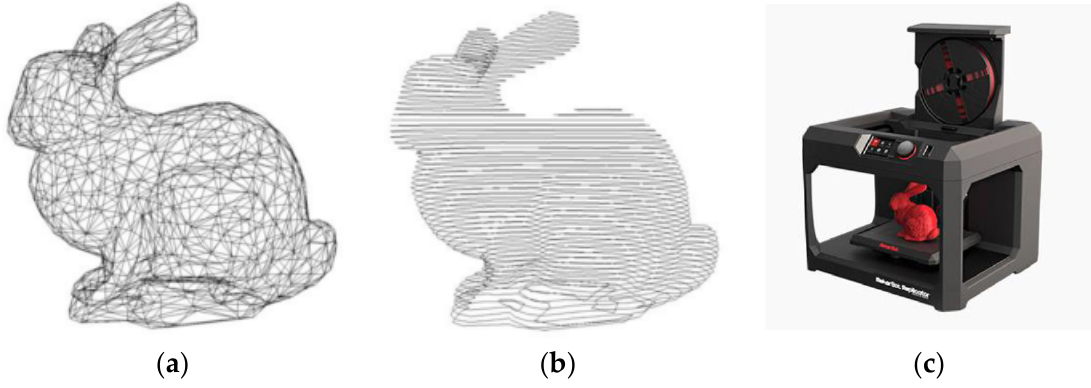
Figure 2. Simplified 3D printing procedure ( a ) Digital model; ( b ) Layered processing; ( c ) Printing process. Table 1. Summary of major 3D printing techniques.